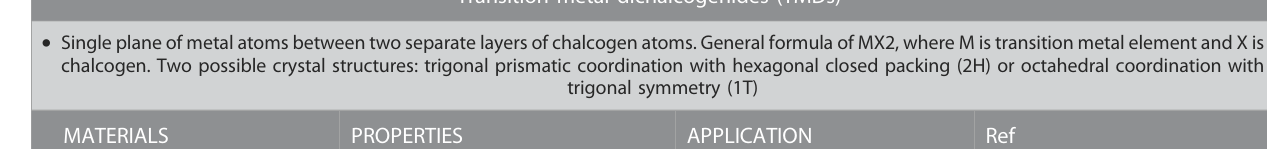
TABLE 3 Properties and applications of 2D materials beyond graphene. Transition metal dichalcogenides